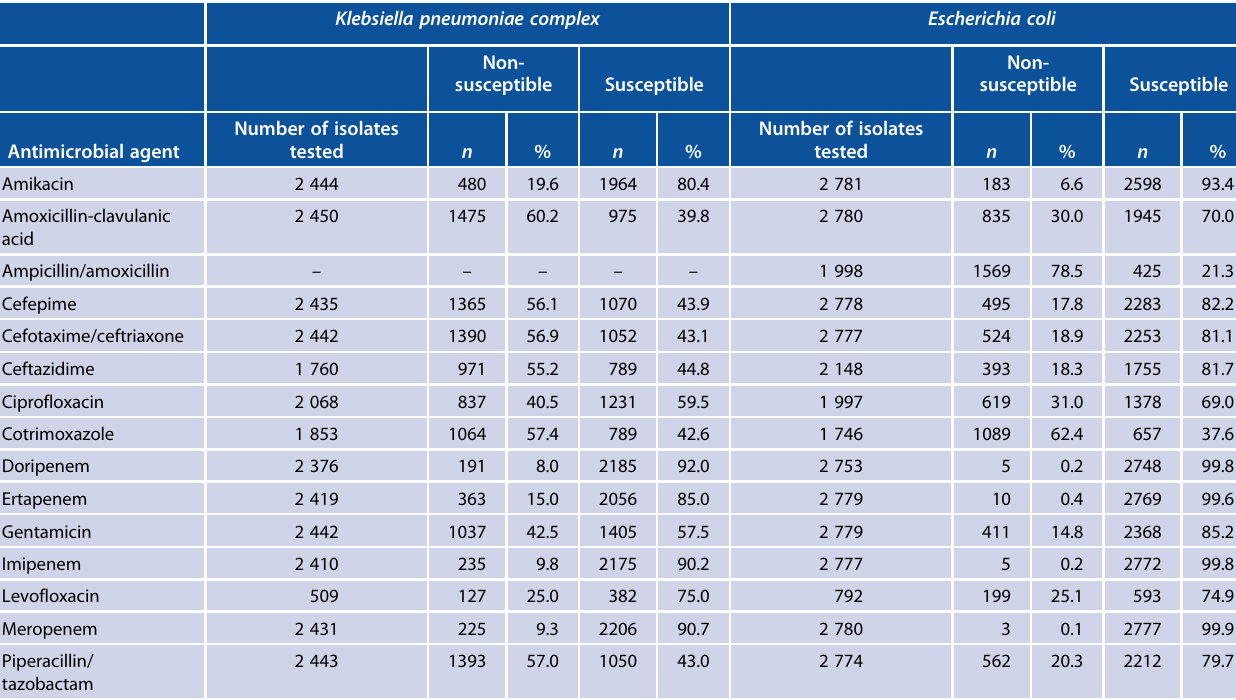
Table 1: Antimicrobial susceptibility patterns of Enterobacteriaceae isolated from blood cultures reported from four private groups in South Africa, January 1, 2016 to December 31,